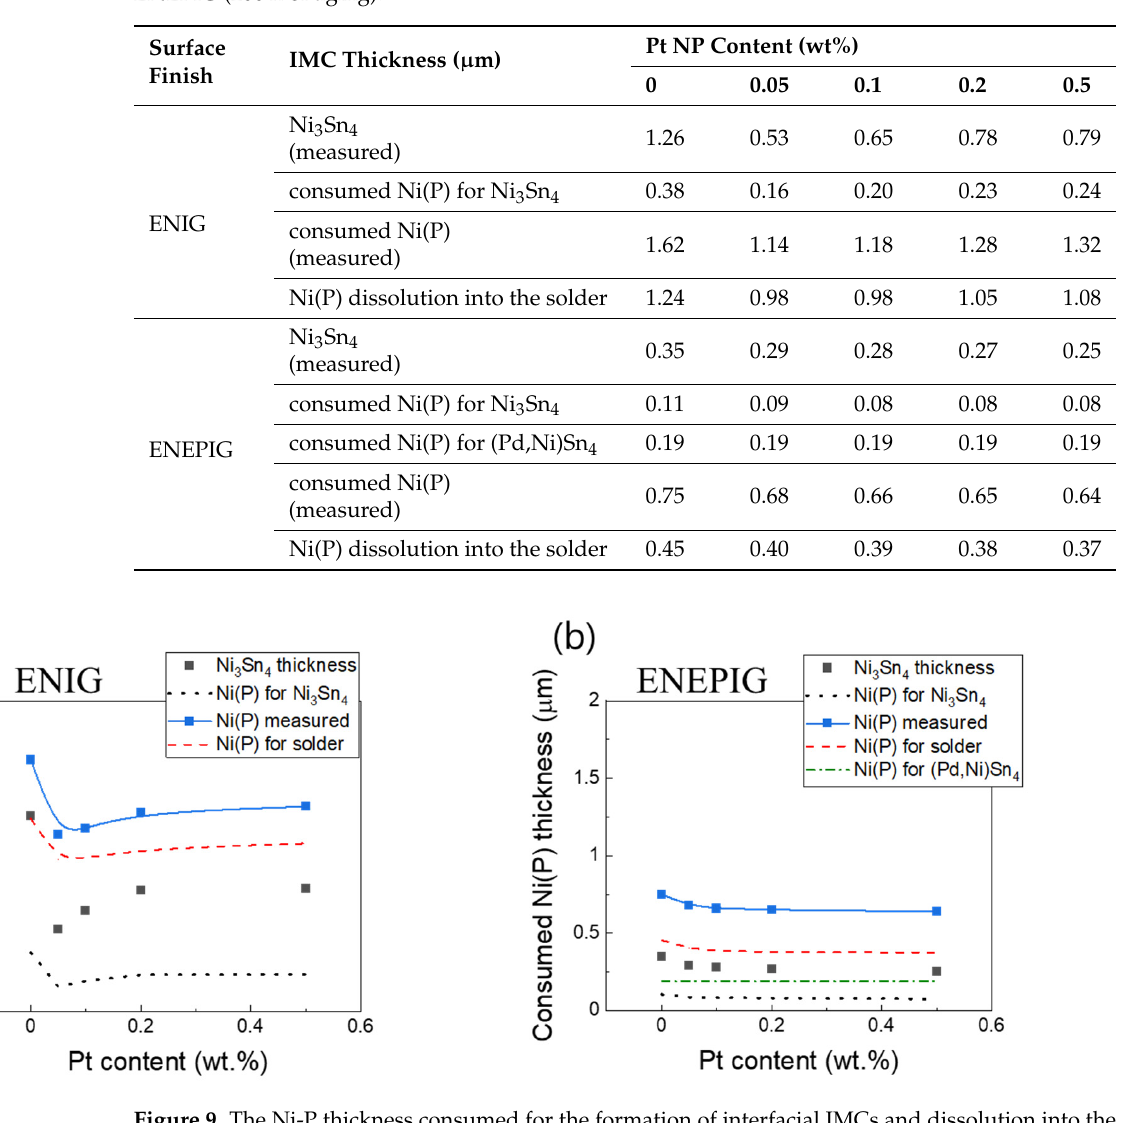
Figure 9. The Ni-P thickness consumed for the formation of interfacial IMCs and dissolution into the molten solder: ( a ) ENIG and ( b ) ENEPIG (200 h of aging). The thickness ∆ h of Ni-P consumed for the reactions between Sn-58Bi-xPt and ENEPIG can be calculated with Equation (2).